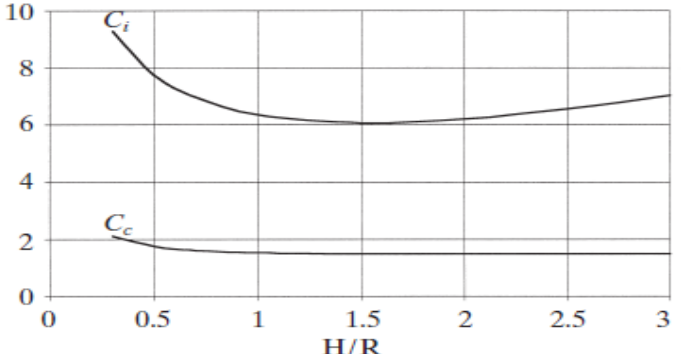
Fig. 4. Impulsive and convective coefficients (Malhotra et al., 2000)